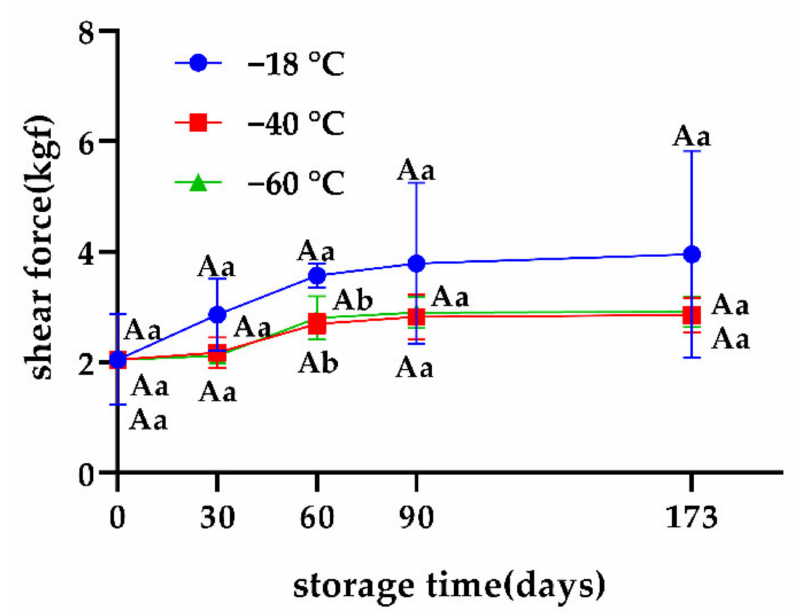
Figure 5. Effects of different freezing storage temperatures on shear force of snowflake beef ( n = 4); ab represents significant differences of different freezing temperatures for the same storage time; A represents significant differences of different freezing times for the same storage